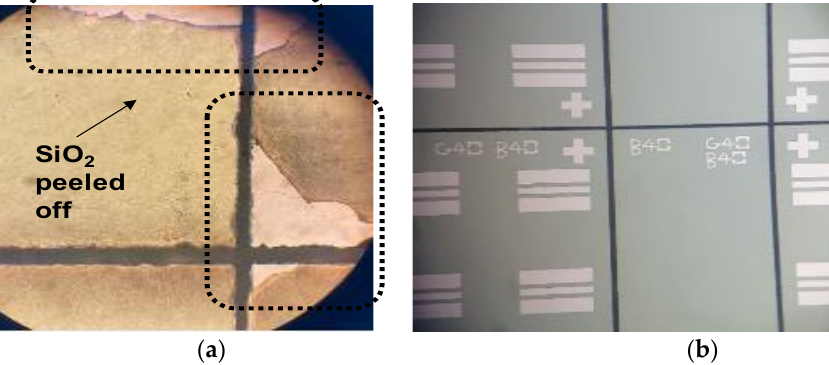
Figure 6. Microscope images after dicing process: ( a ) dicing process where a dielectric removal process was not included; ( b ) dicing process where a dielectric removal process was included.